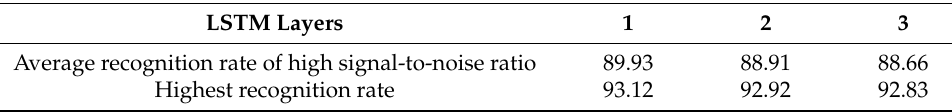
Table 2. Influence of LSTM layers on model recognition